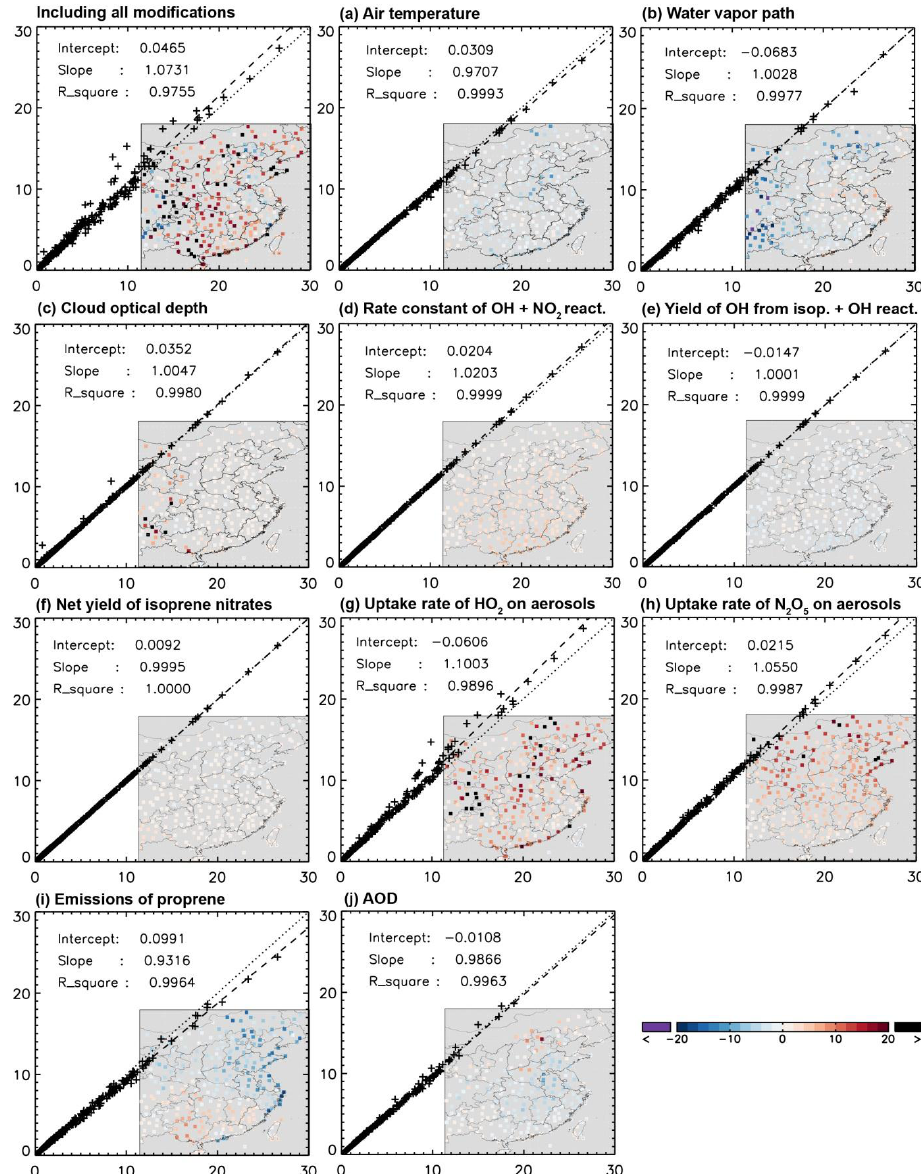
Fig. 14. 2 Fig. 14. Similar to Fig. 13 but for January